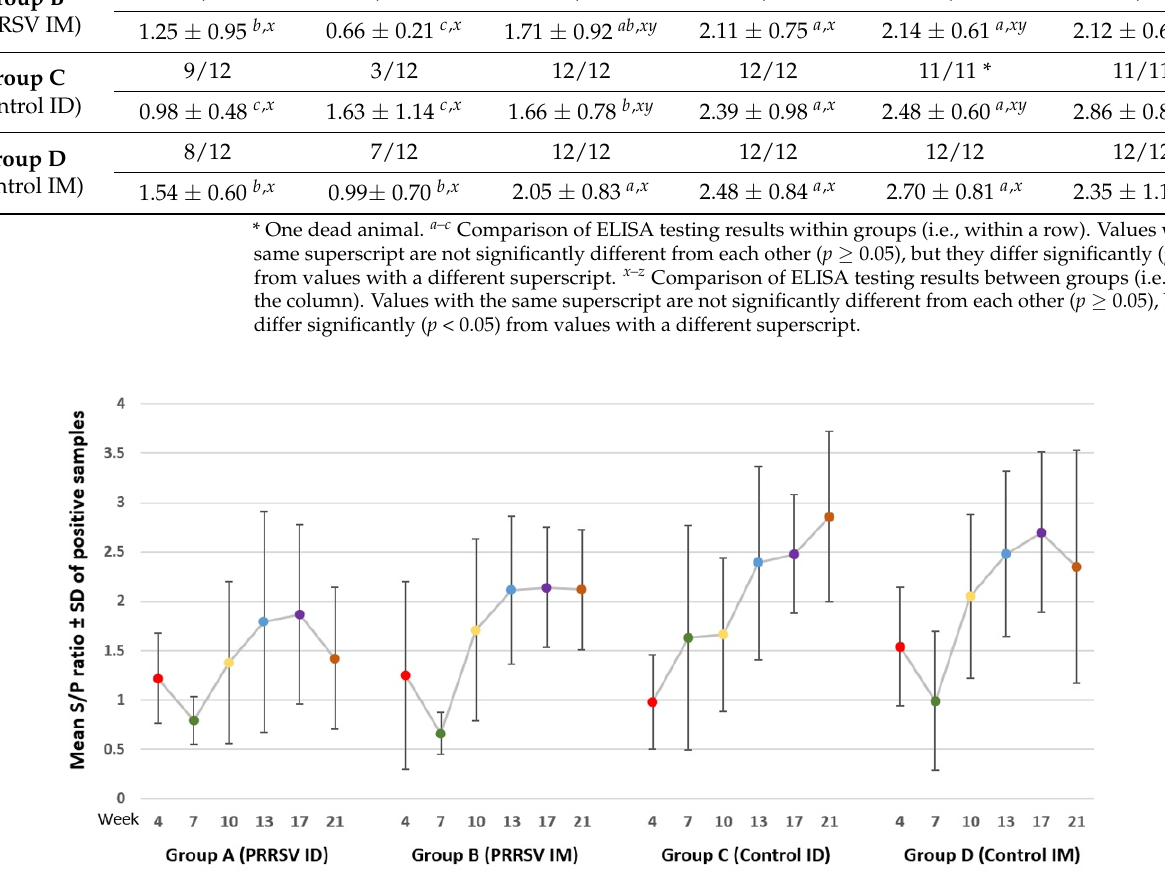
± SD) antibody-positive serum